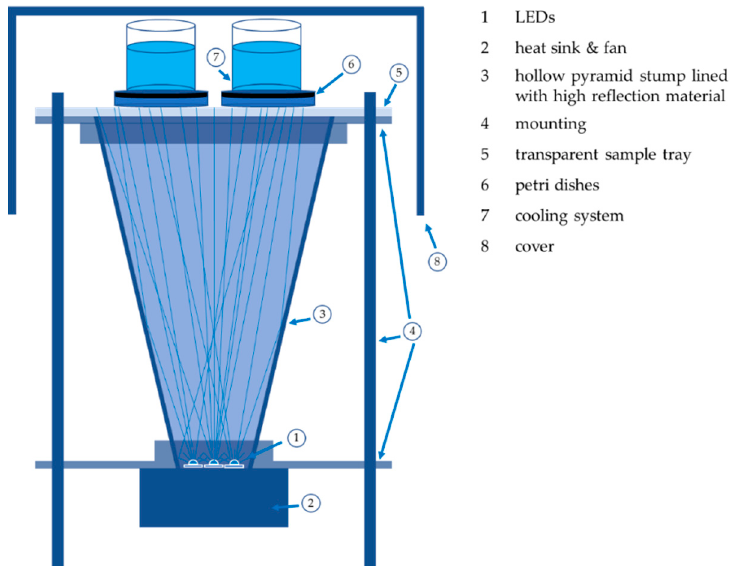
Figure 4. Irradiation set-up: The LEDs were cooled by a heat sink and the radiation was emitted into a pyramid stump with a reflective coating. The resulting homogenized radiation illuminated the legionella, which were incorporated into the cooled agar plates.